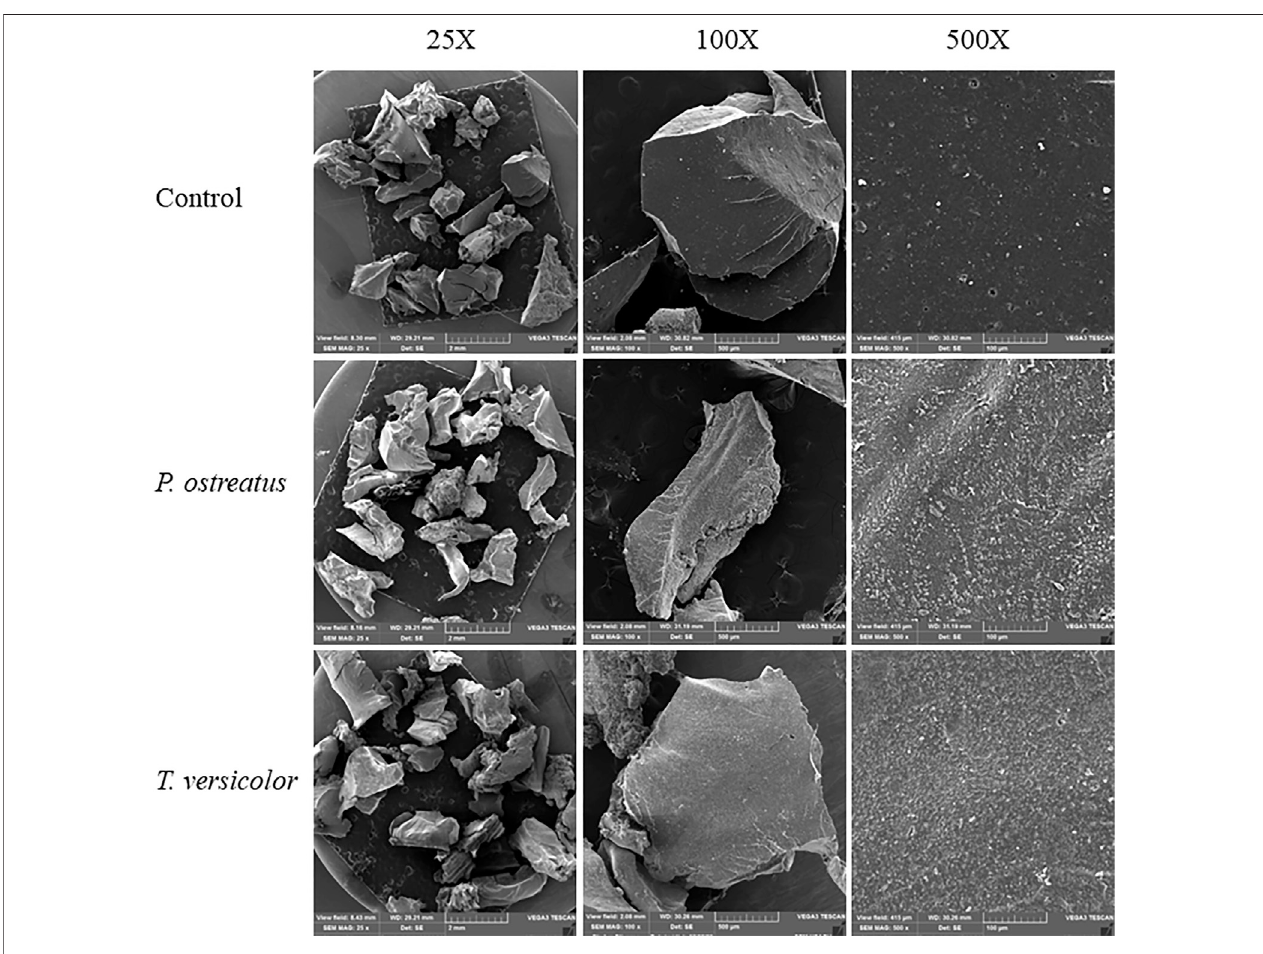
FIGURE 3 | SEM-EDS analysis of vulcanised rubber particles.